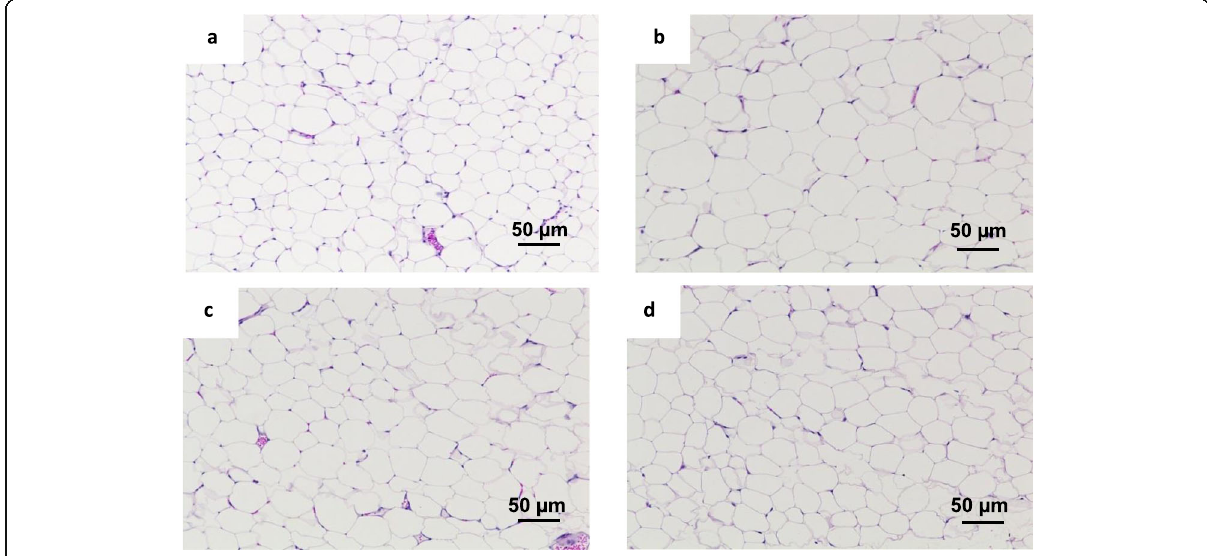
Fig. 7 Histology of epididymal adipose tissue of experimental rats; a : Normal Diet fed rat showing normal architecture of adipocytes; b : HFD fed obese rat showing increased size of adipocytes; c : AEAA (300mg/kg bw) and d : Standard Drug (Orlistat) treated rat ’ s adipocyte with decreased